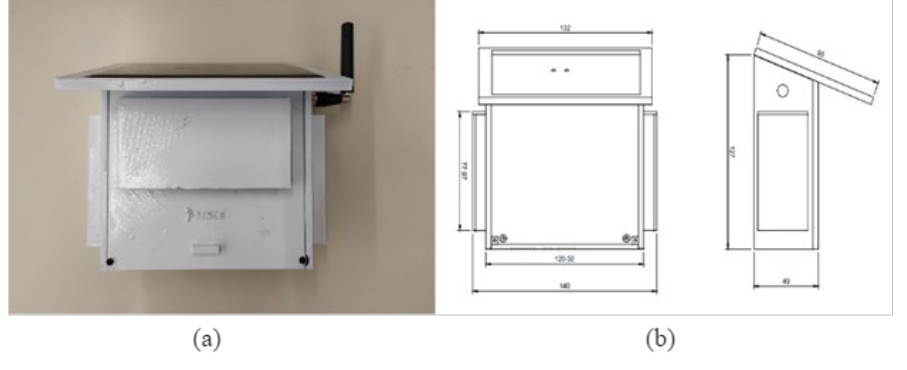
Figure 5. Smart Tag’s case: ( a ) Design and ( b )